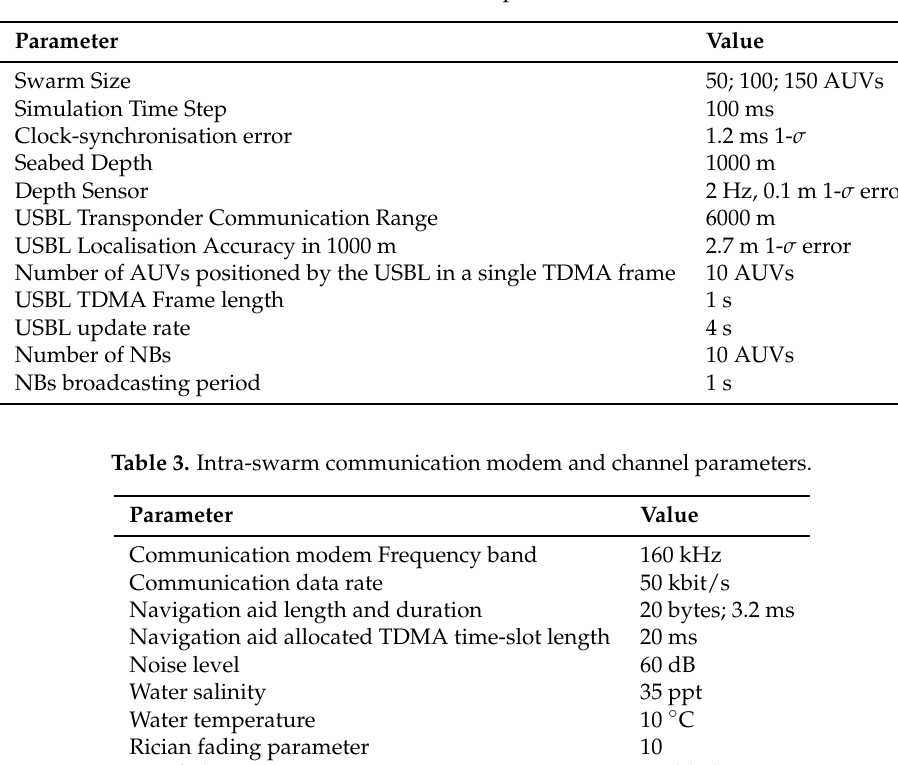
Table 2. Simulation parameters.